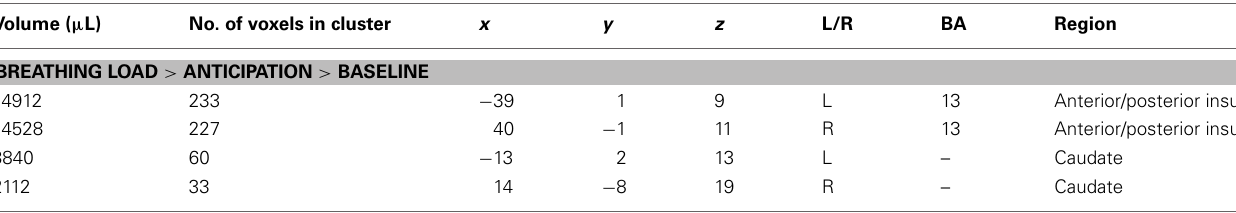
Table 4 | fMRI results for the main effect of interoception condition.